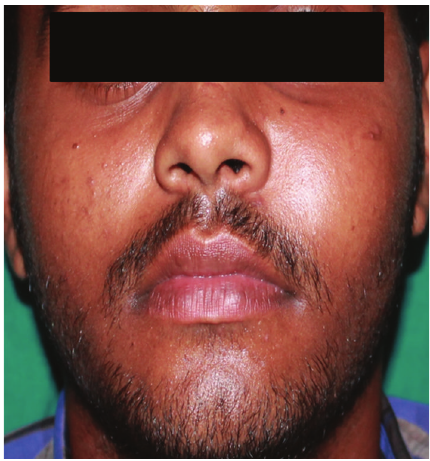
Figure 1: Profile picture showing swelling over the left middle third of face.